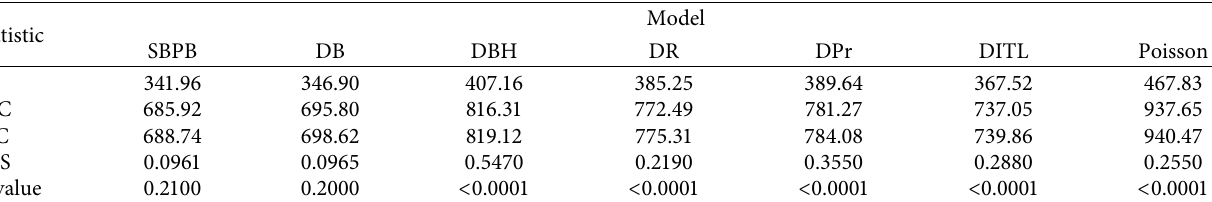
Table 16: Te GOF measures for data set IV.